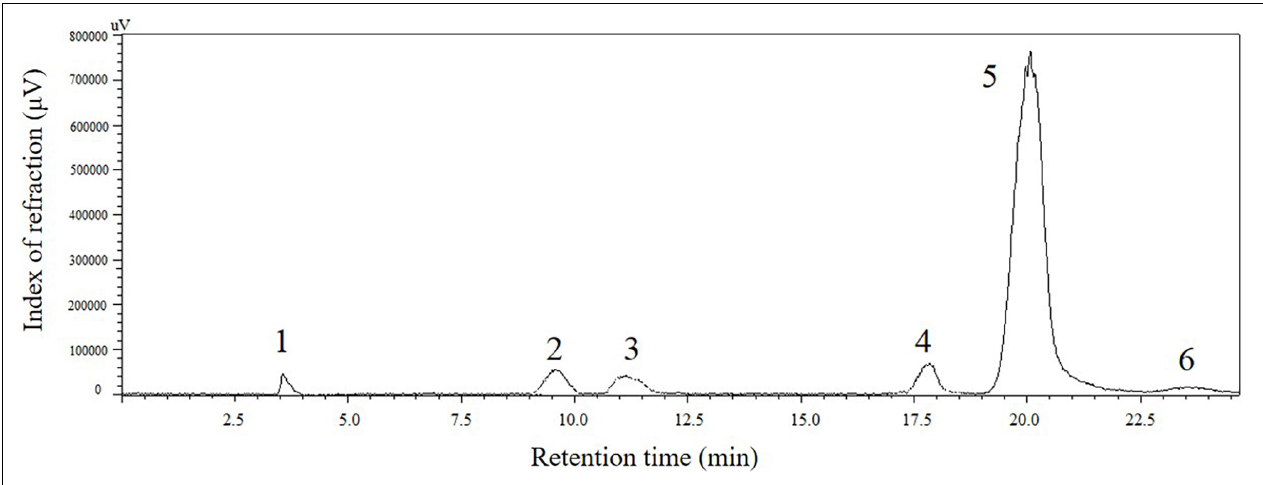
FIGURE 5 | High-performance liquid chromatography (HPLC) profile of products in catalytic liquid of pretreated BM using immobilized SIase in the eighth cycle at 10 h. The numbers from 1 to 6 represent solvent, glucose, fructose, sucrose, isomaltulose, and trehalulose, respectively.